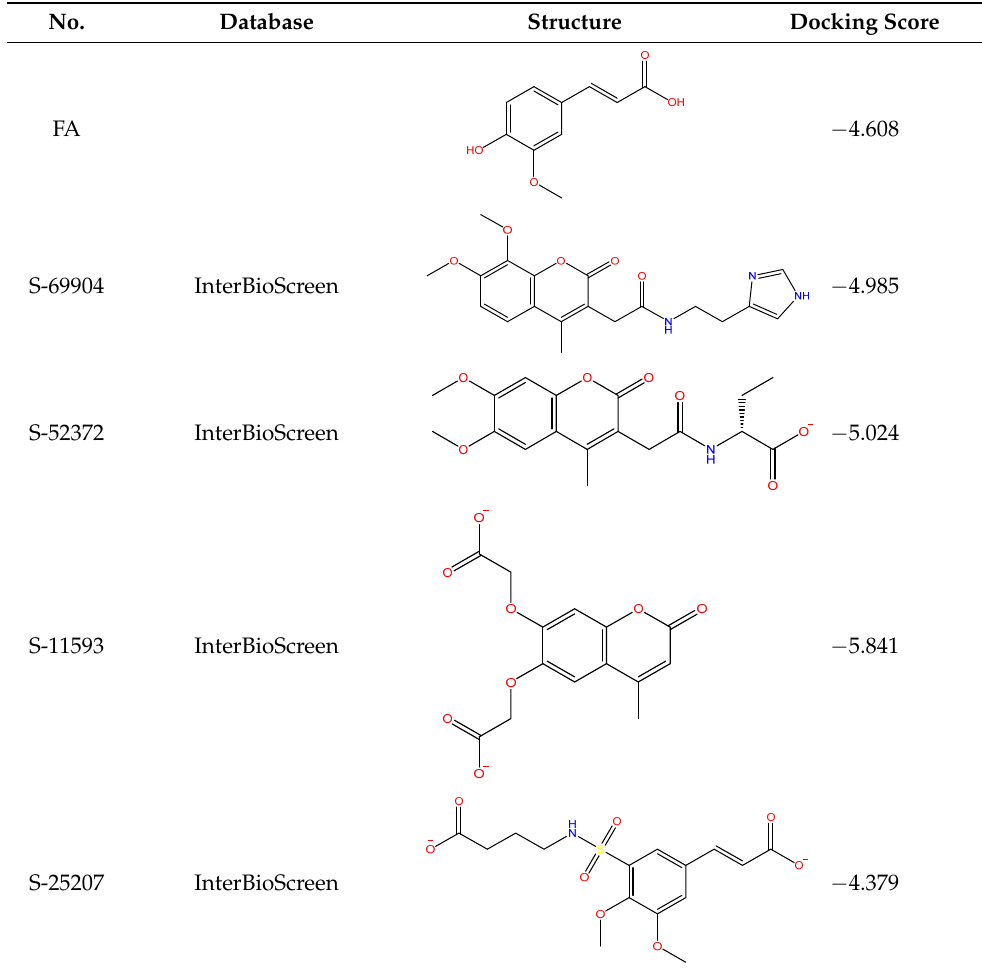
Table 1. The obtained potential derives by virtual screening.